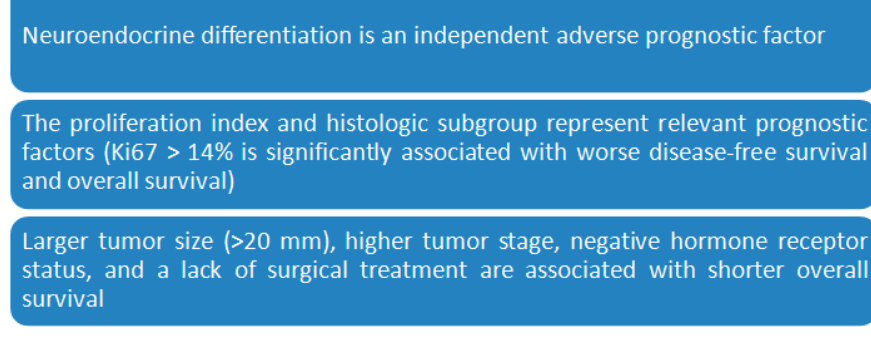
Table 1. Prognostic factors in neuroendocrine breast cancer.